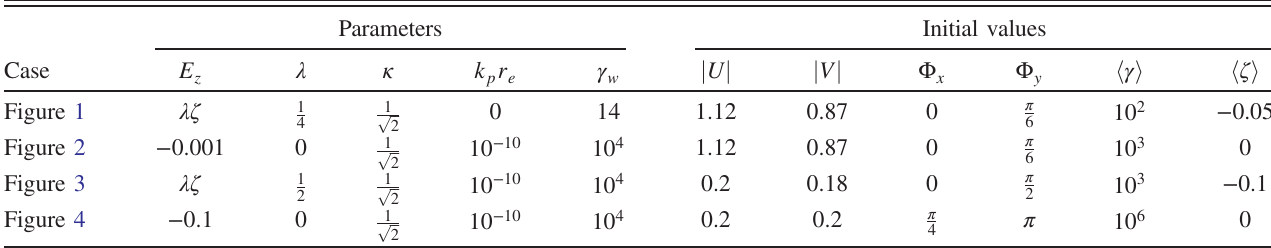
TABLE II. The cases for comparing PT and LTEs.